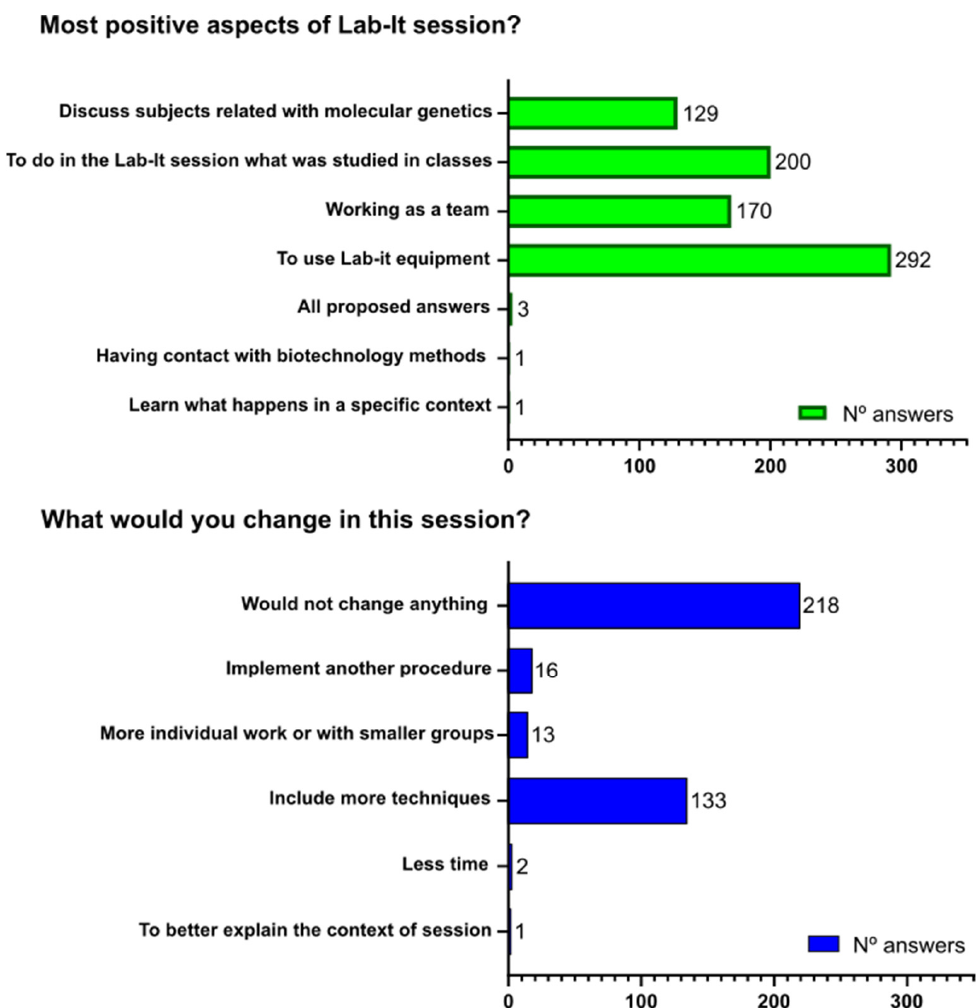
Figure 2. Compilation of opinions about what were the most positive aspects of Lab-it activities and what would students change in the sessions.